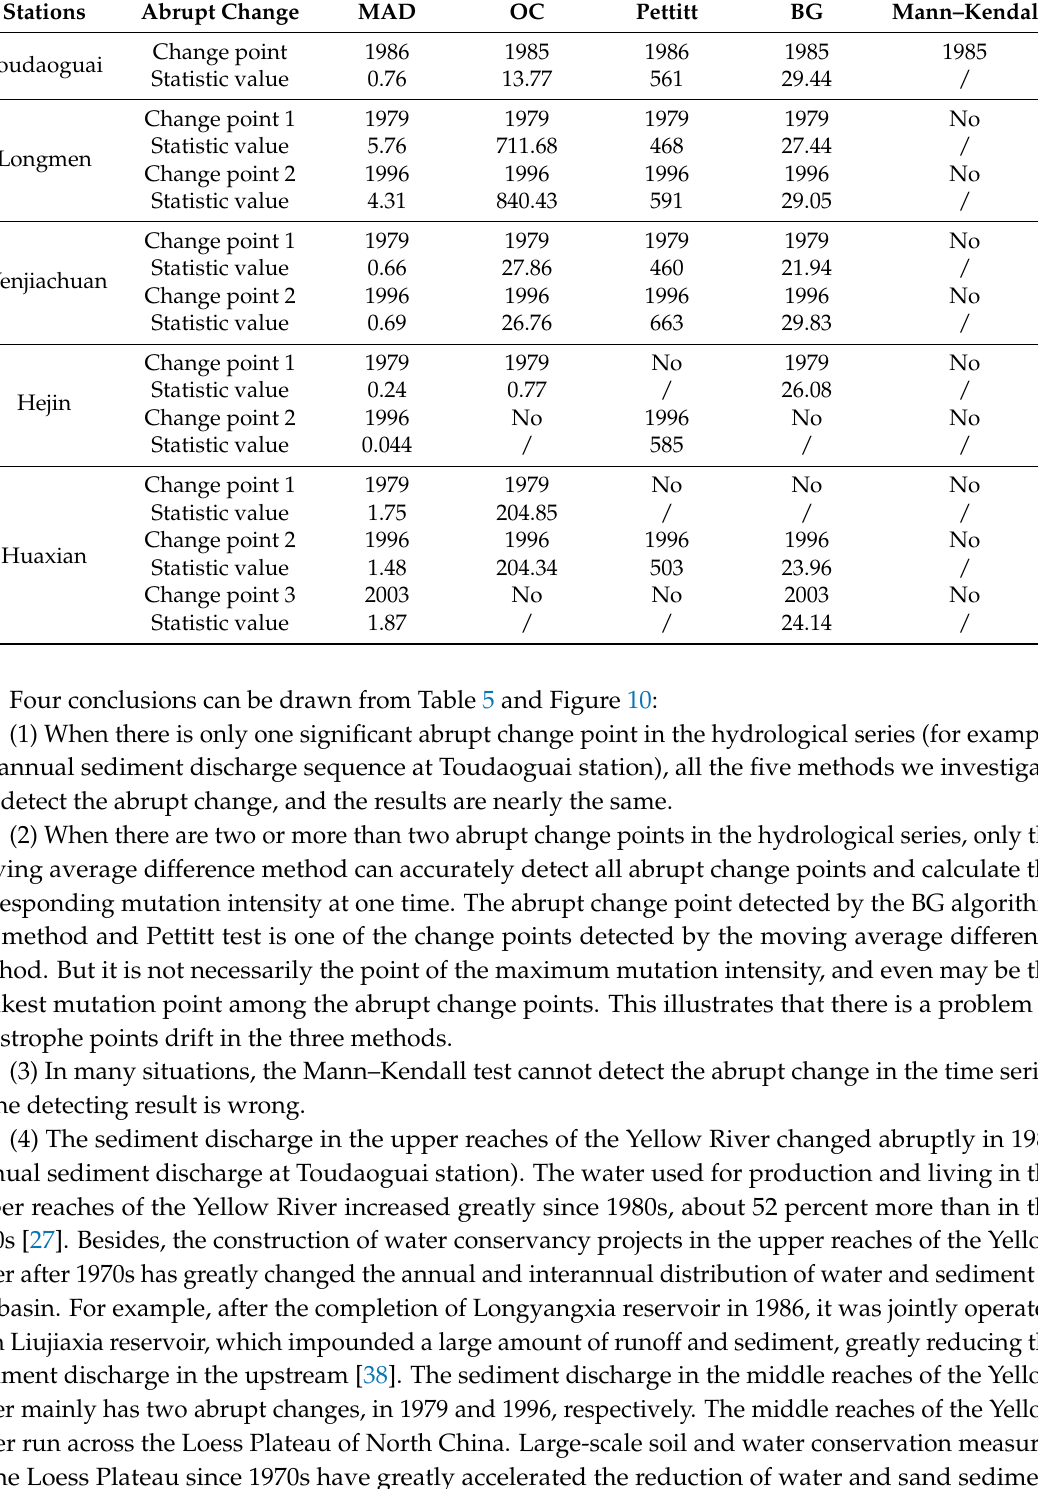
Table 5. Detecting results of sediment discharge of other stations.